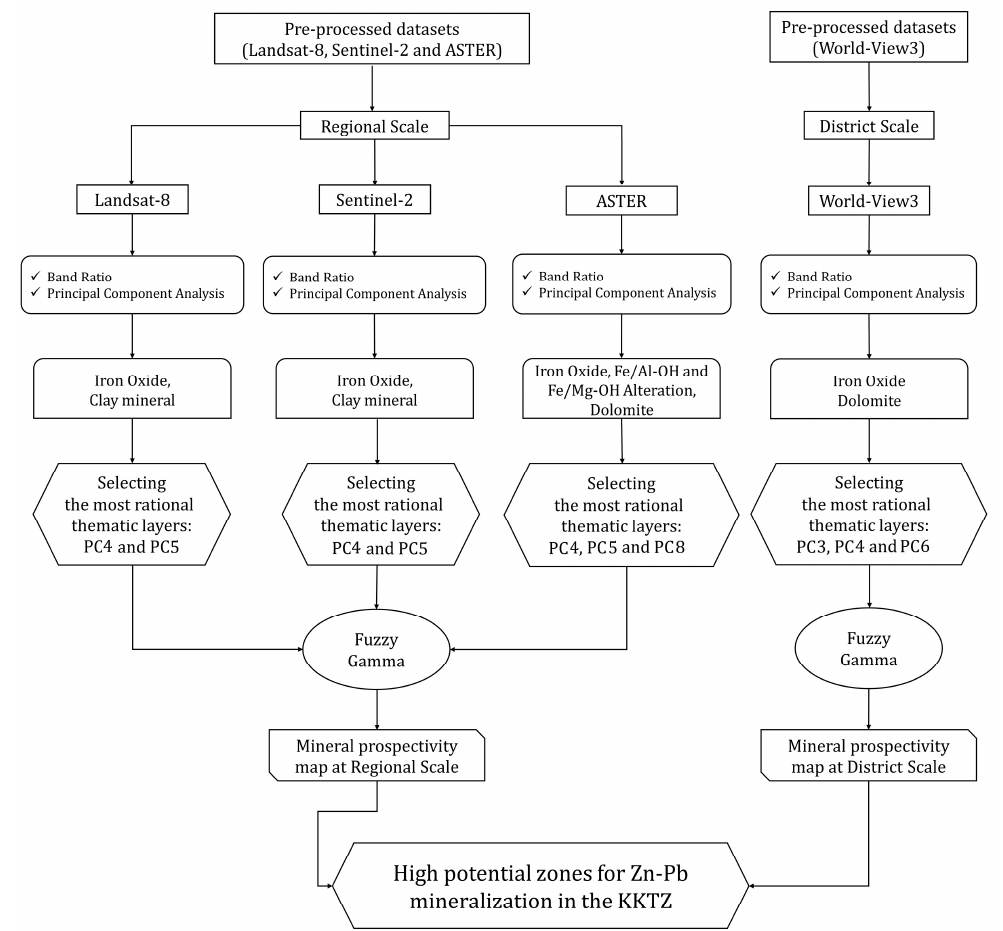
Figure 2. An overview of the methodological flowchart used in this study.